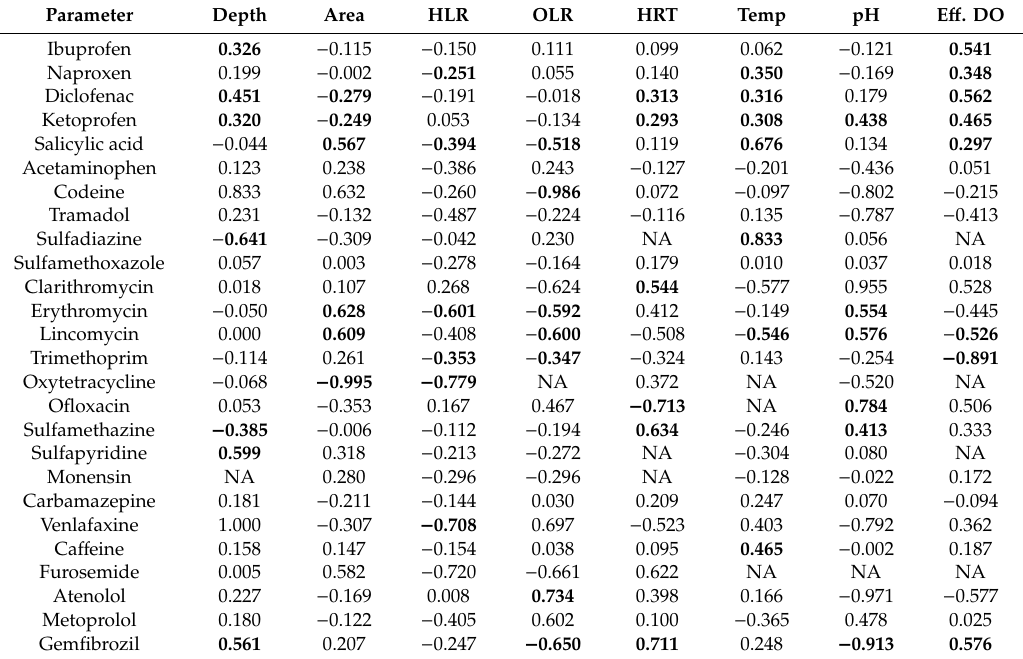
Table 4. Pearson correlation statistics among the studied factors and the removal e ffi ciency of 26 selected